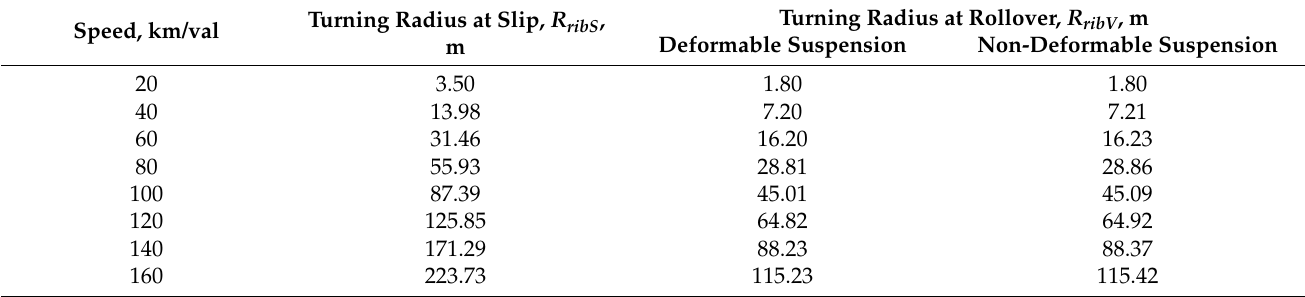
Table 3. Vehicle boundary turning radius.